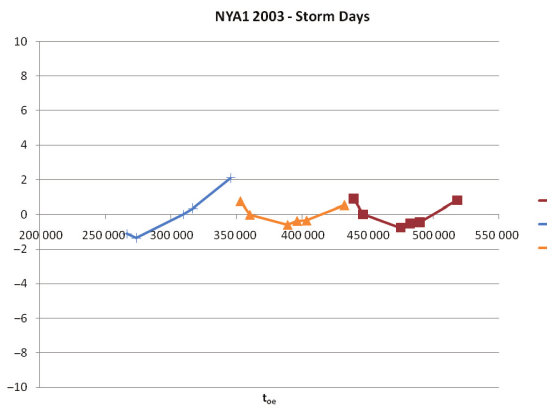
Fig. 4. The eccentricity of three stormy days in 2003 using cPOS stations (KRSS)